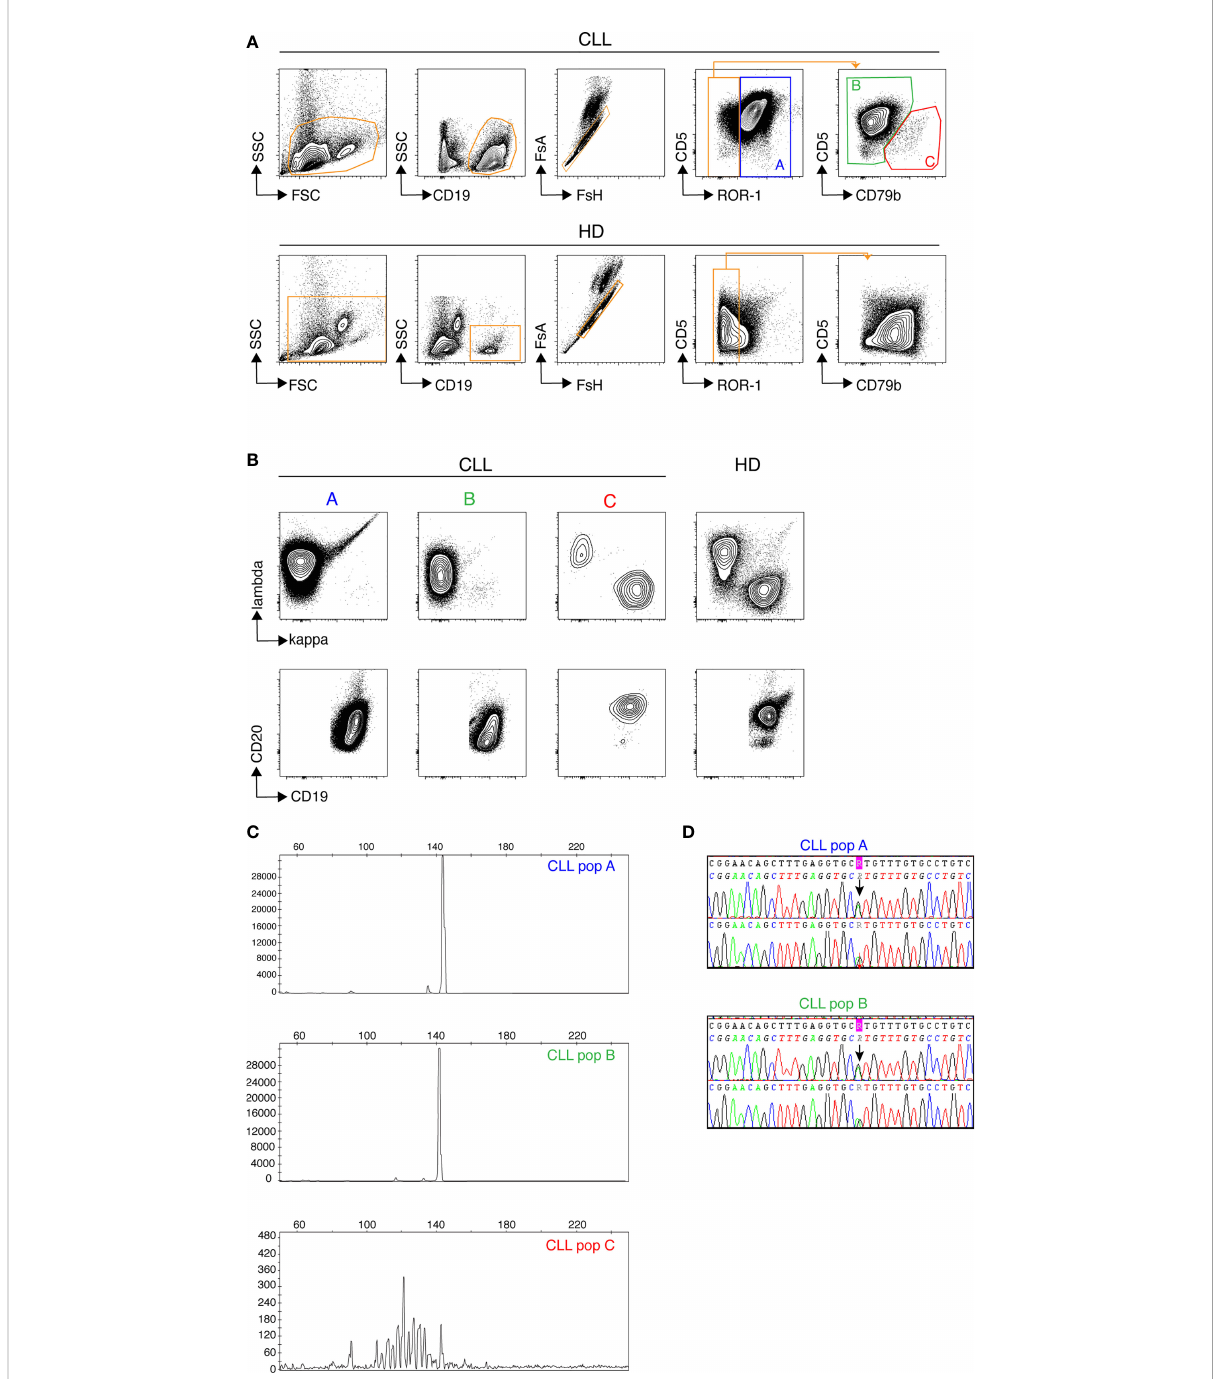
FIGURE 1 Discrimination of non-malignant and tumoral B cells from CLL samples by fl ow cytometry. Samples from healthy donors (HD) and CLL patients were stained with a cocktail of 7 fl uorochrome-conjugated Abs recognizing, CD5, CD19, CD20, CD79b, ROR-1, Ig k and Ig l light chains. (A) Gatings from left to right: morphology, B cells, single cells, CD5/ROR-1 expression and CD5/CD79b expression within the ROR-1 lo/- gate. Results from one CLL (top row) and one representative HD (bottom row) sample are shown. (B) Expression of Ig k /Ig l (top row) and CD20/CD19 (bottom row) by the (A – C) subsets. One representative CLL patient (3 contour plots on the left) and one representative HD (4 th contour plots on the right). (C) Assessment of clonality by analysis of HCDR3 length in sorted CLL subsets (A – C) delineated in (A) , one representative result chosen among three. (D) Results of TP53 mutational analysis in populations (A, B) performed by Sanger sequencing showing the presence of a common TP53 mutation in populations (A, B) from the same